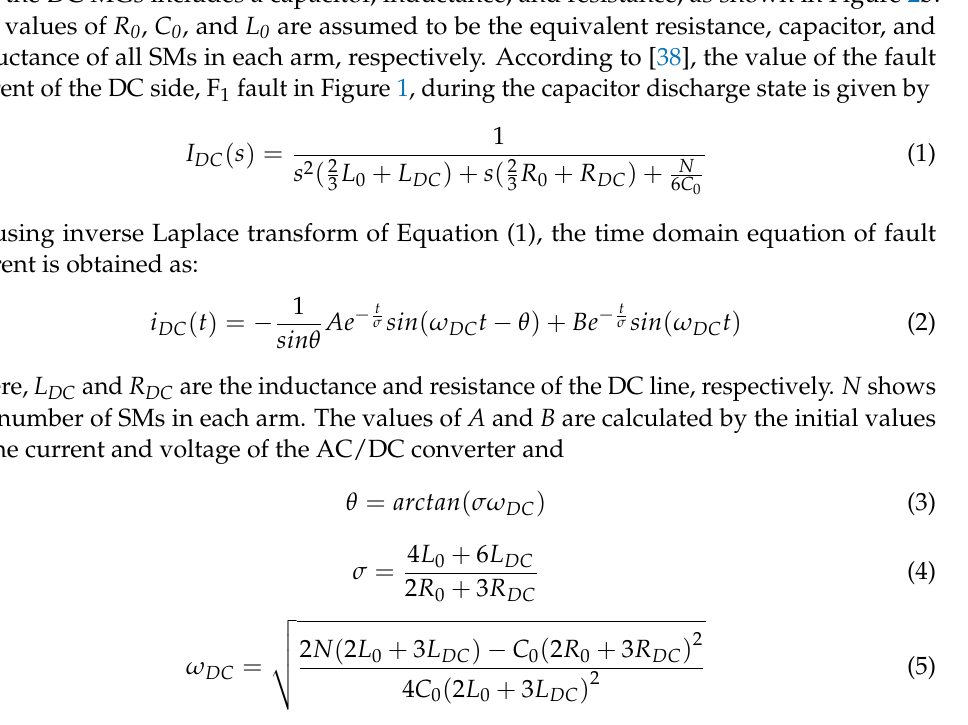
Figure 3. Structure of a bidirectional DC/DC converter.